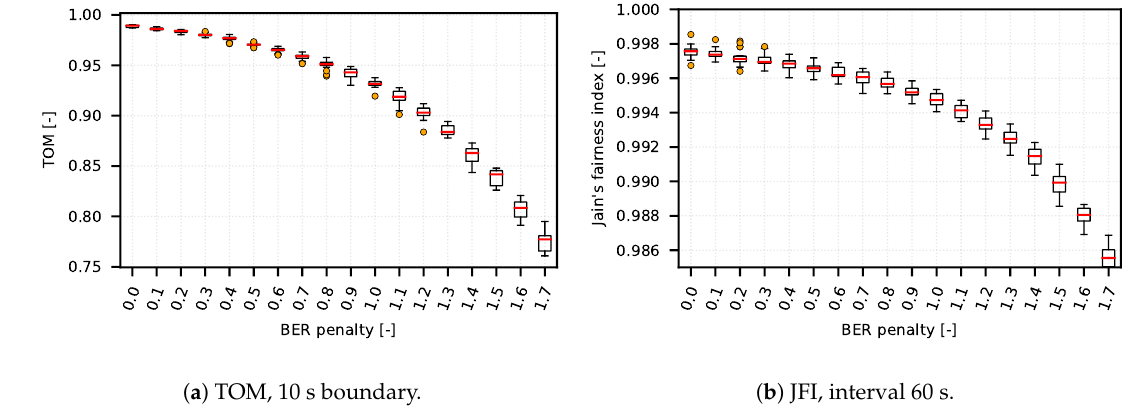
Figure 5. Scenario TDMA, TOM and JFI